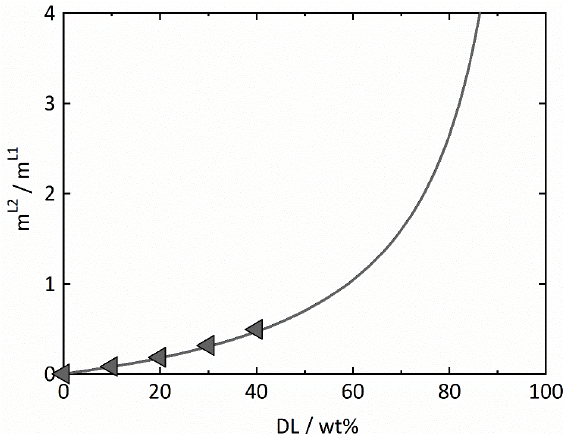
Figure 4. Equilibrium mass ratio of the RIT-rich (L2) and RIT-poor (L1) phases for RIT/PVPVA ASDs stored at 25 °C and 94% RH. The gray solid line denotes PC-SAFT-based prediction. Gray triangles are values obtained from mDSC experiments after optimizing Equation (14).